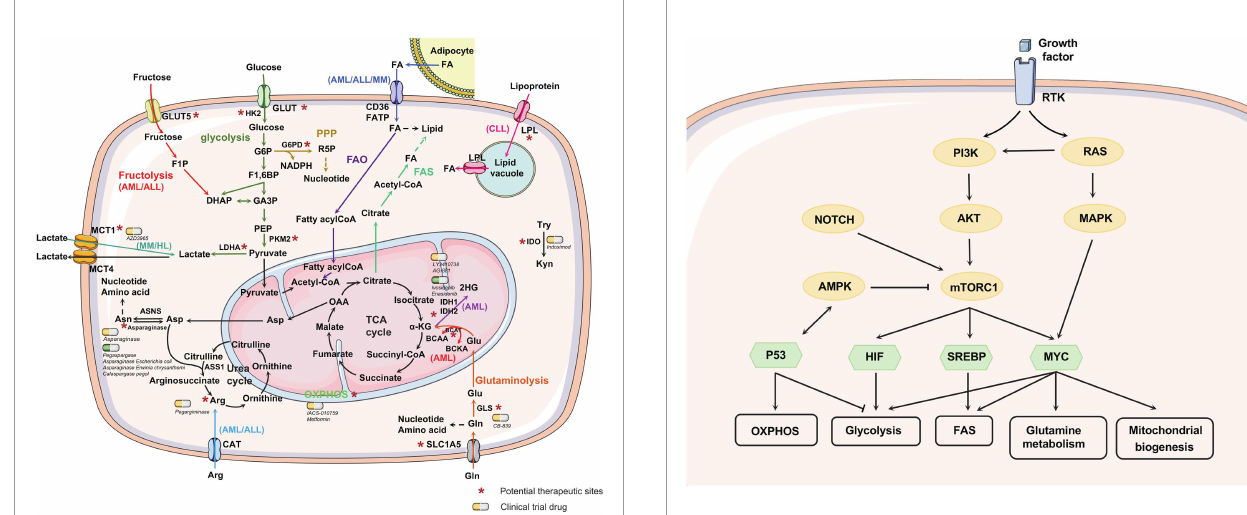
FIGURE 3 | Signaling pathways that regulate metabolism. Growth factors affect metabolism by activating RTKs, and the PI3K/AKT axis can be activated as downstream of RTK and RAS. mTORC1, downstream of PI3K/ AKT, can be activated upon AKT-mediated phosphorylation or suppressed through AMPK-mediated phosphorylation. NOTCH1 signaling promotes the activation of PI3K-AKT-mTOR signaling. PI3K-AKT-mTOR signaling can alter metabolism by regulating multiple transcription factors, nutrient transporters, and phosphorylating metabolic enzymes. HIF, MYC, and SREBP-1 are downstream transcription factors of mTORC1 that promote glycolysis, glutamine metabolism, fatty acid synthesis, and mitochondrial biogenesis. MYC can collaborate with HIF to enhance the expression of genes involved in glucose uptake and glycolysis, including LDHA, pyruvate dehydrogenase kinase-1 (PDK-1), and HK-2. Apart from this, MYC targets function to enhance mitochondrial biogenesis and function, especially glutamine downstream effector of mTORC1 can induce the expression of several key enzymes related to fatty acid and sterol biosynthesis, such as ATP citrate lyase (ACLY) and fatty acid synthase. Moreover, SREBP interacts with MYC to regulate lipogenesis and then promote tumorigenesis. P53 forms a positive feedback loop with AMPK to repress glycolytic activity and promote OXPHOS and PPP. Phosphoserine STAT3 binds to and activates the promoter of LPL.